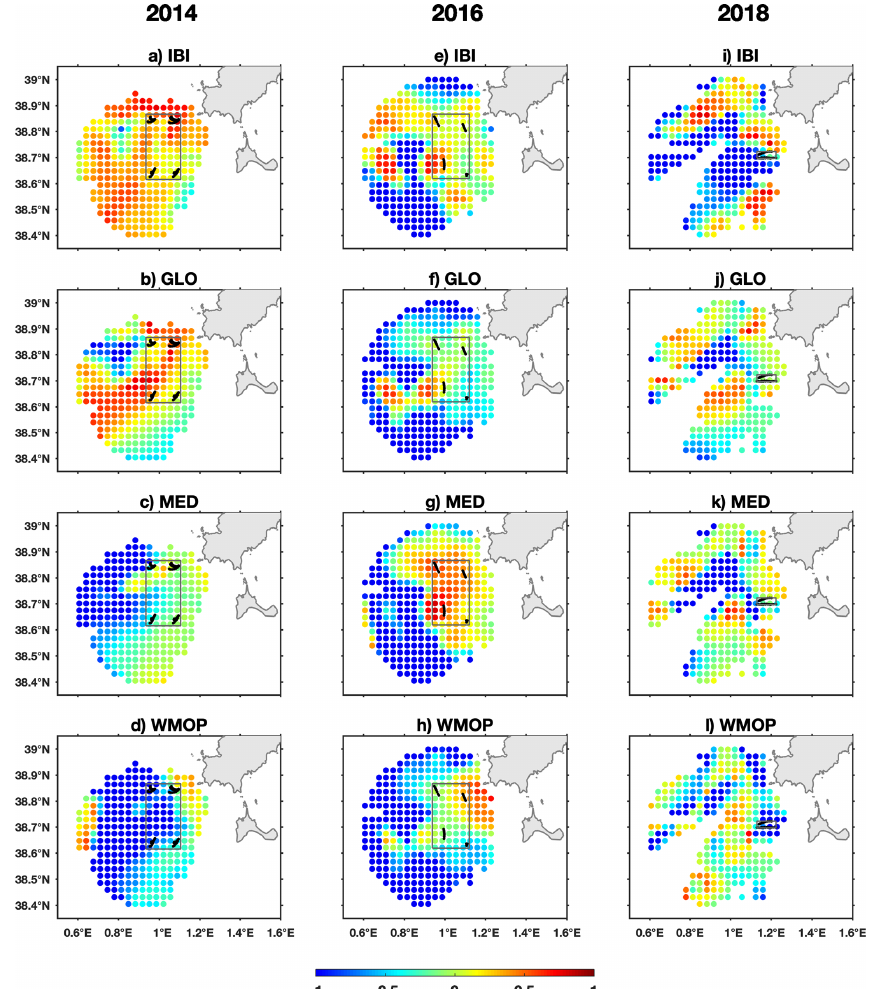
Figure 2. Temporally averaged skill score SS ∗ obtained for four models as indicated in the title of each panel by comparing against the HFR-derived trajectories of the Ibiza Channel during a forecast time of 6h. Simulated trajectories are initialized hourly at each grid point on 30 September 2014 from 13:00 to 16:00 (a–d) , on 28 July 2016 from 16:00 to 22:00 (e–h) , and on 15 November 2018 from 13:00 to 16:00 (i–l) . SS ∗ values, with red representing the higher average model performance, are only obtained in those grid points with data temporal availability equal to or higher than 80%. Black lines show the drifter paths available during the same periods, and the boxes indicate the regions where the averages are applied for comparison with the results obtained with drifter observations. Original source: from Révelard et al.